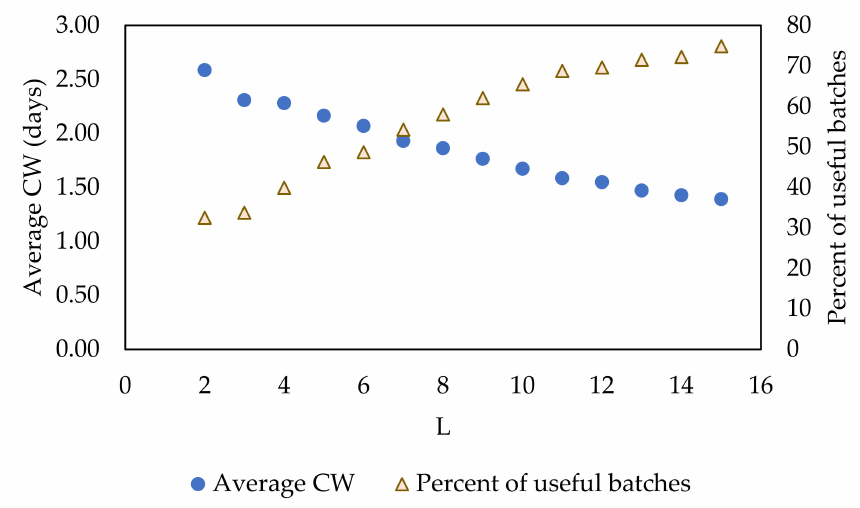
Figure 3. Average CW per order and percentage of useful batches for different L values.